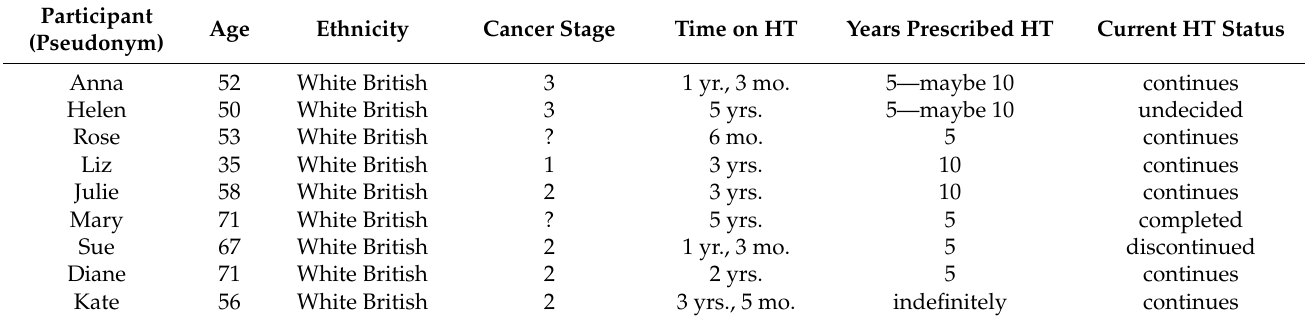
Table 1. Participant